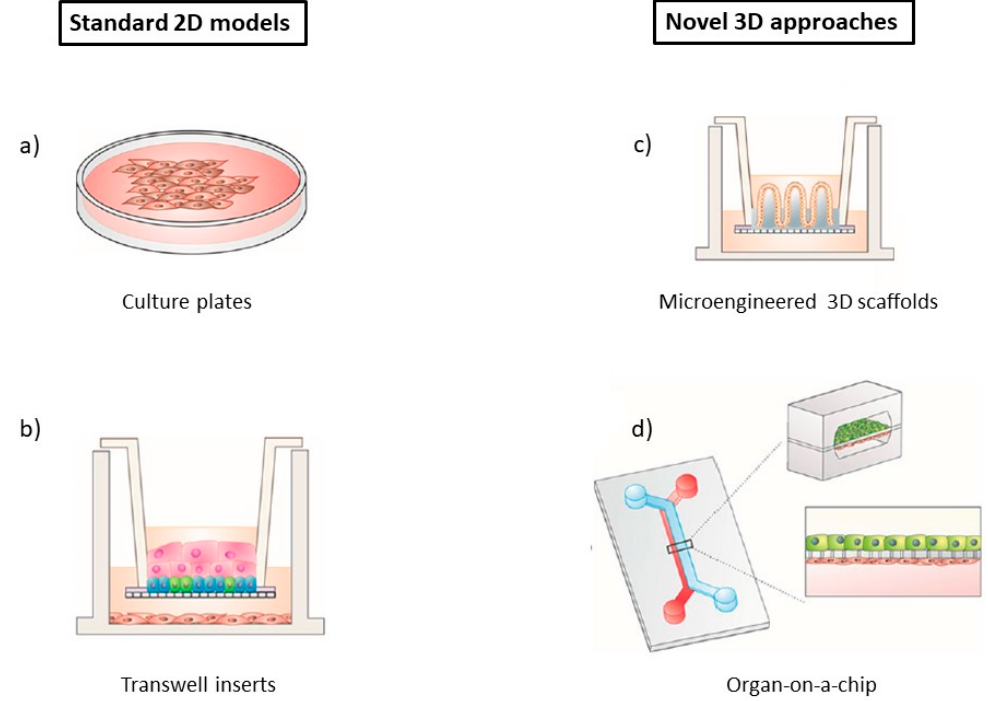
Figure 2. Schematic representation of different 2D and 3D in vitro models: ( a ) culture plates, ( b ) Transwell inserts, ( c ) microengineered scaffolds, ( d ) organ-on-a-chip. Reprinted and adapted with permission from Torras et al. [44].